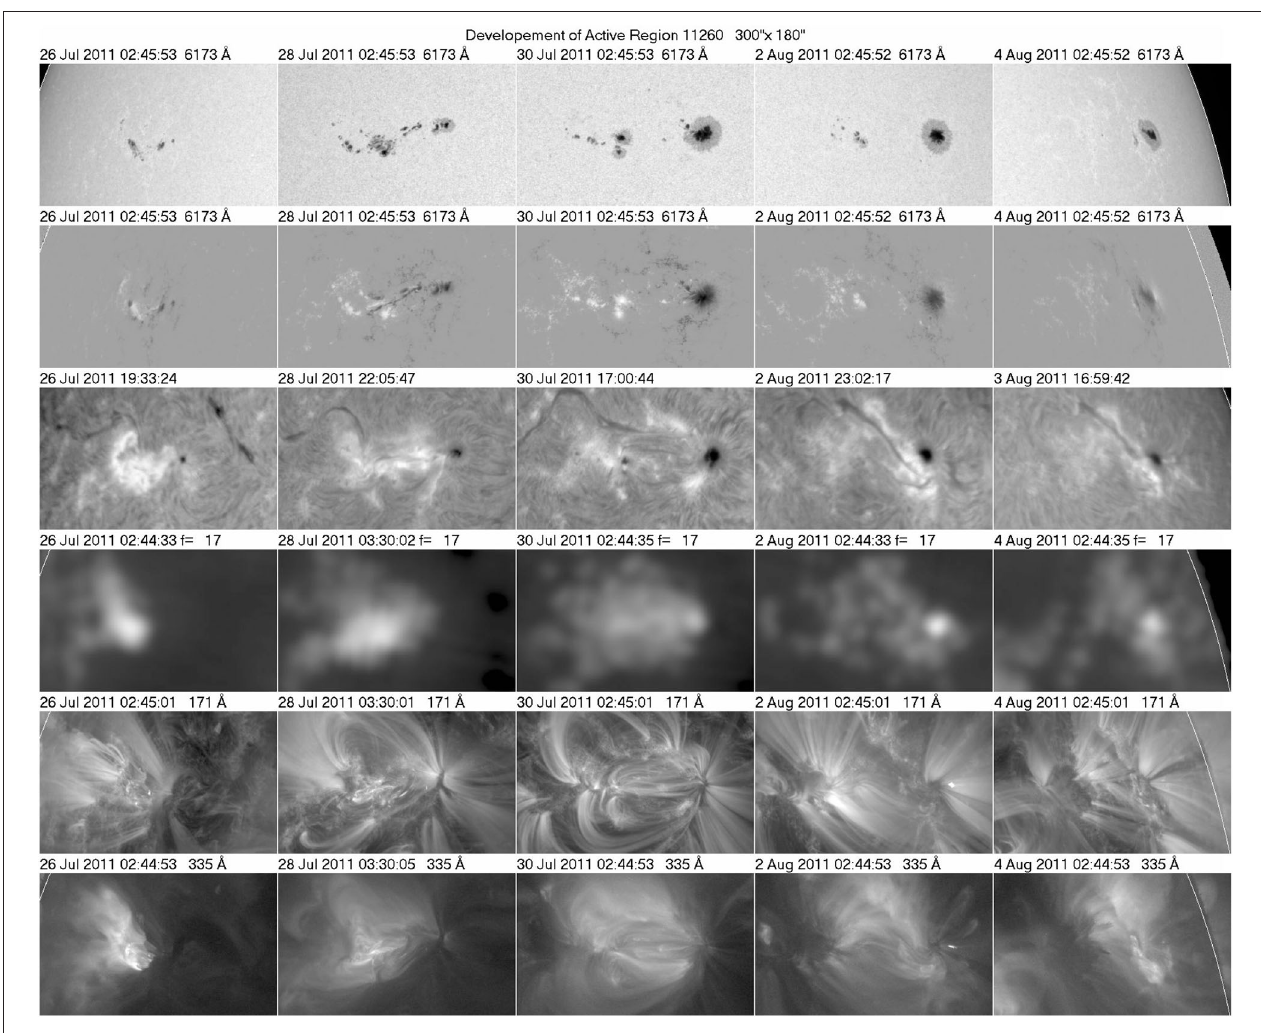
FIGURE 14 | Development of Active Region 11260 during its passage on the solar disk. Sunspots and magnetograms from HMI/SDO, H α images from Big Bear, Nobeyama images at 17GHz and AIA/SDO images in the 171Å (Fe IX , log T July 30, 9 UT. The white arc marks the photospheric limb. Figure prepared by the author. ∼